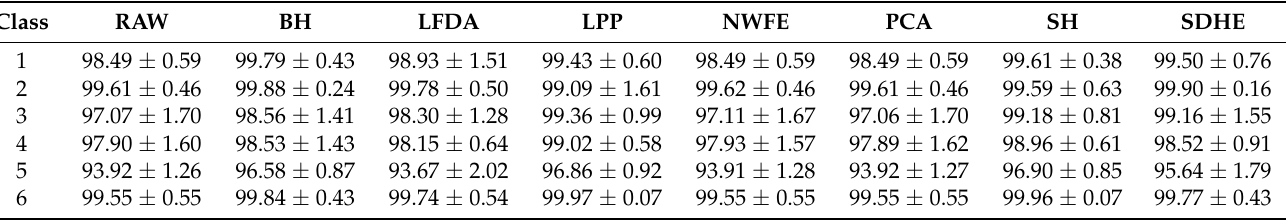
Table 5. Classification accuracy (%) at 30-dimensionality for Salinas with the training set of 20 samples per